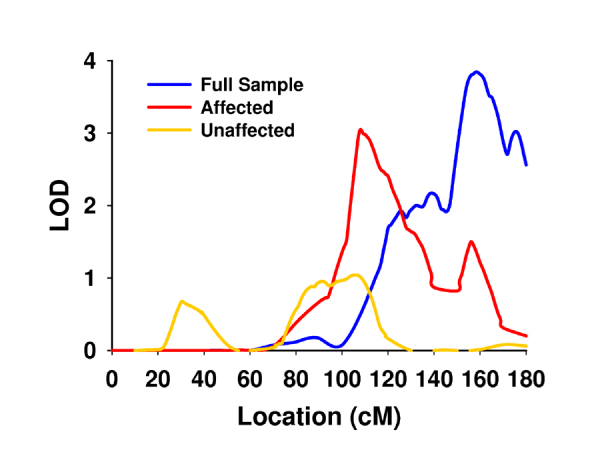
Multipoint LOD scores on chromosome seven in the full dataset and by alcoholism classification.